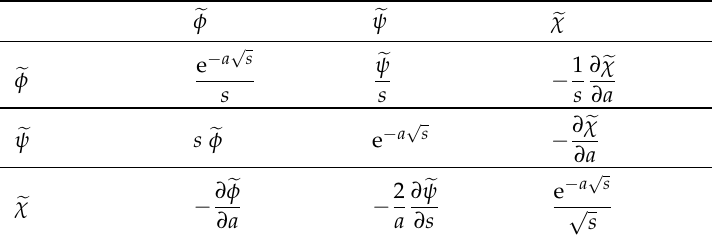
Table A1. Relations among the three sisters in the Laplace